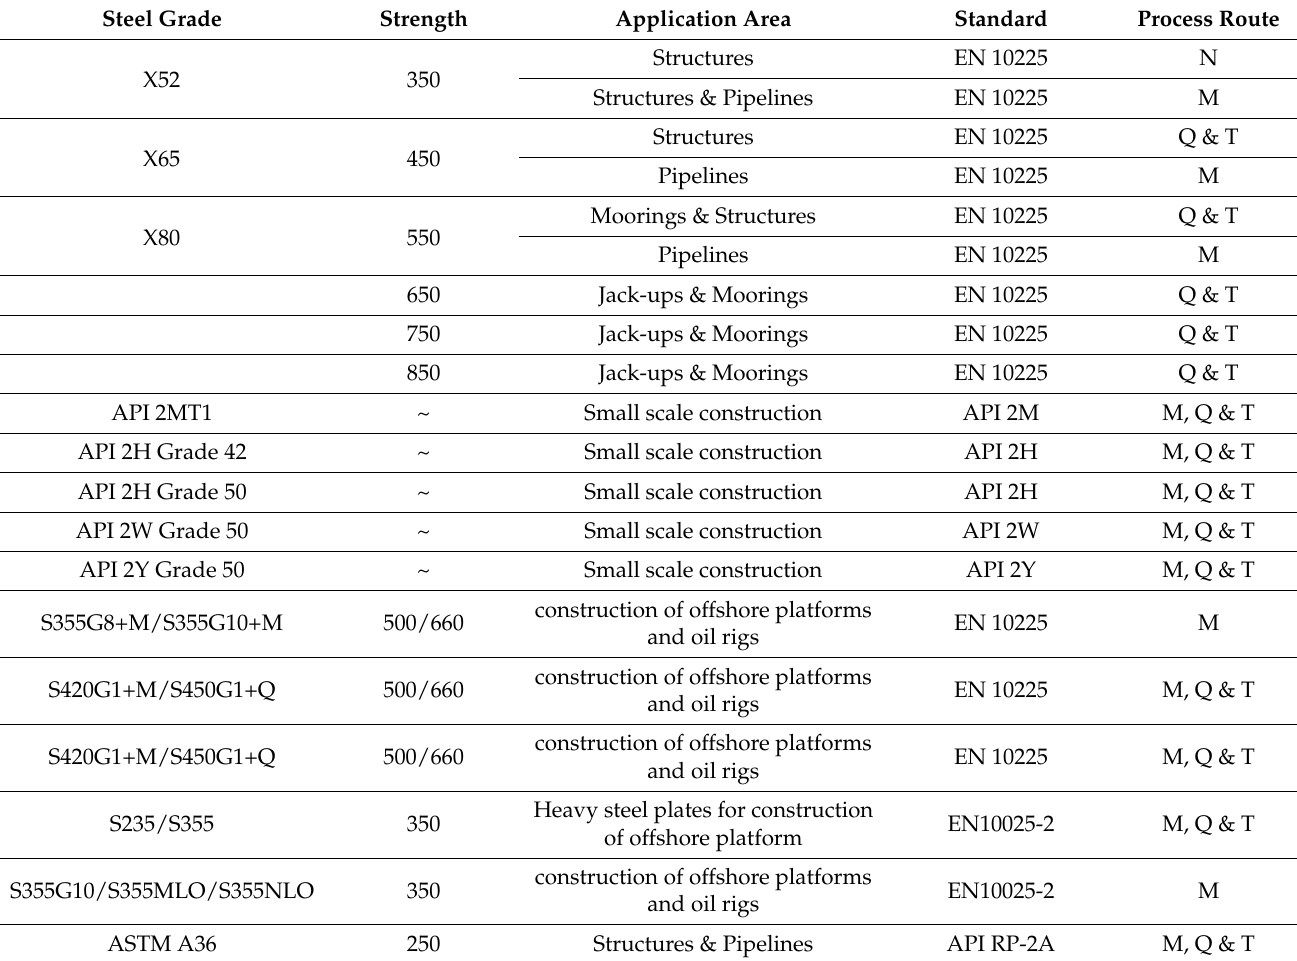
Table 8. Application of some high strength steels in the offshore